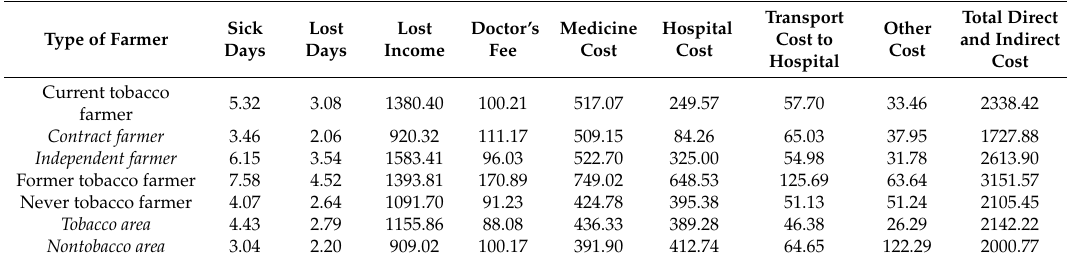
Table 10. E ff ects on health and health